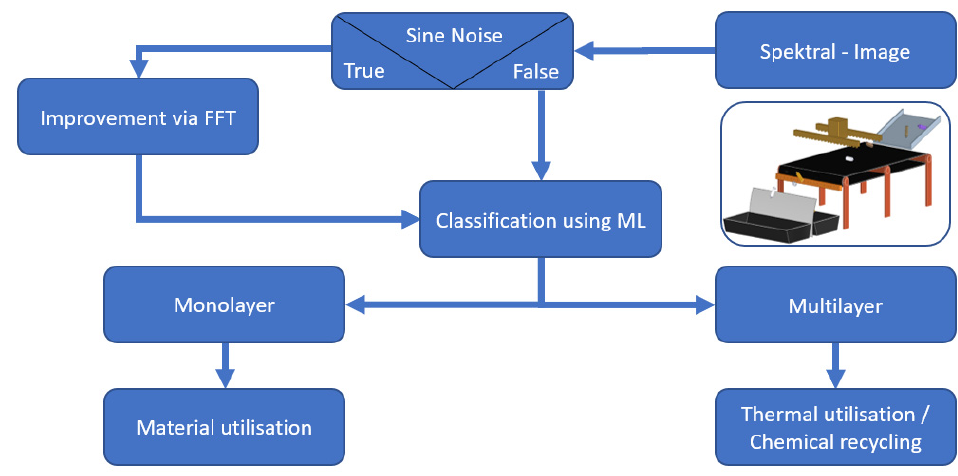
Figure 28. Integrated film recycling